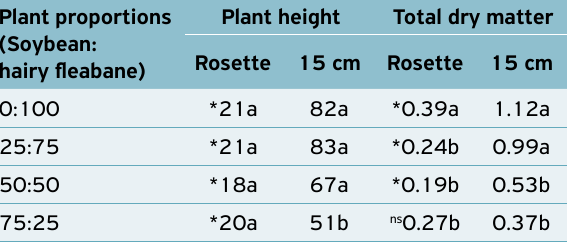
Table 3. Plant height and total dry matter of hairy fleabane of different stages of development (rosette and 15 cm tall) in competition of proportions with Plant proportions